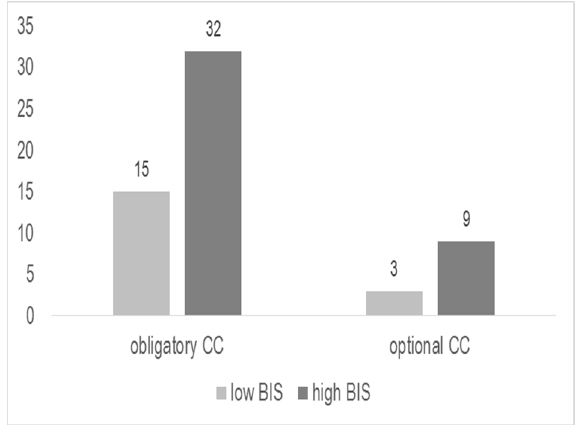
Figure 1. Raw frequencies of clitics occurring in obligatory and optional clitic climbing (CC) contexts across two groups of participants identified based on Bilingual Index Score (BIS): high- and low-BIS bilinguals.